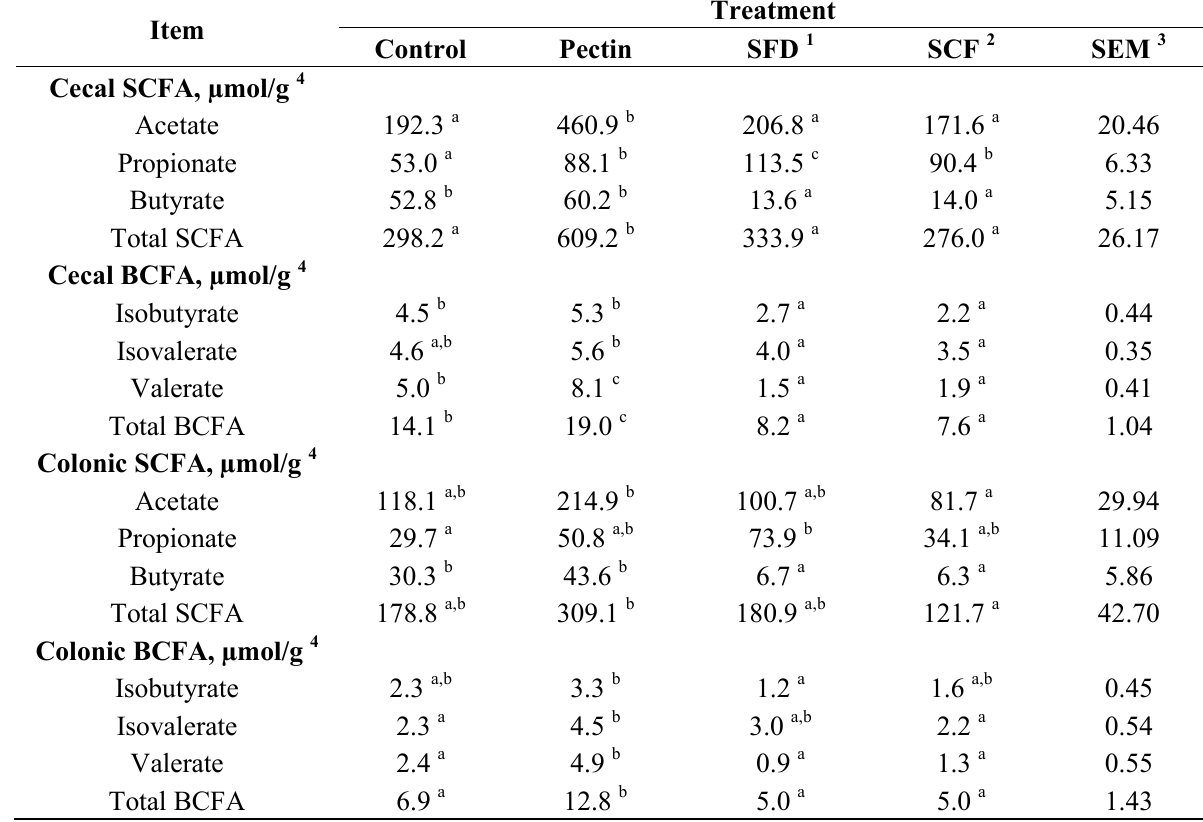
Table 5. Concentrations of short-chain fatty acids (SCFA) and branched-chain fatty acids (BCFA) in cecal and colonic contents of rats fed select dietary